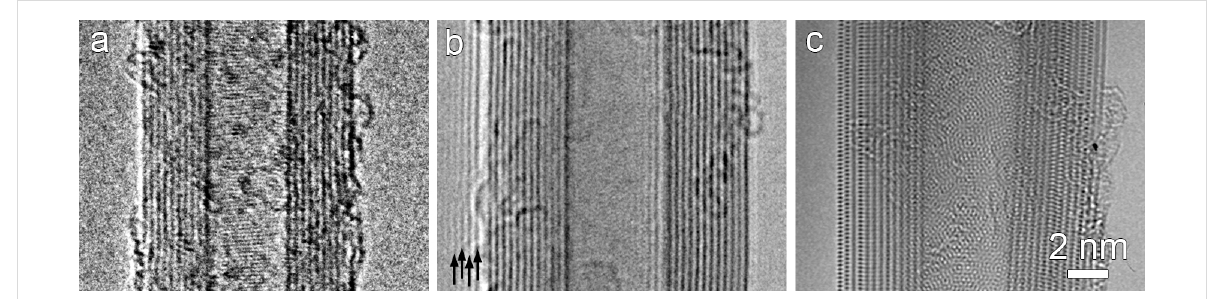
Figure 2: HRTEM images of MWCNTs acquired (a) at 200 kV without Cs correction; (b) at 120 kV without Cs correction, where delocalization is indi- cated by arrows; and (c) at 80 kV with Cs correction using a monochromated beam.